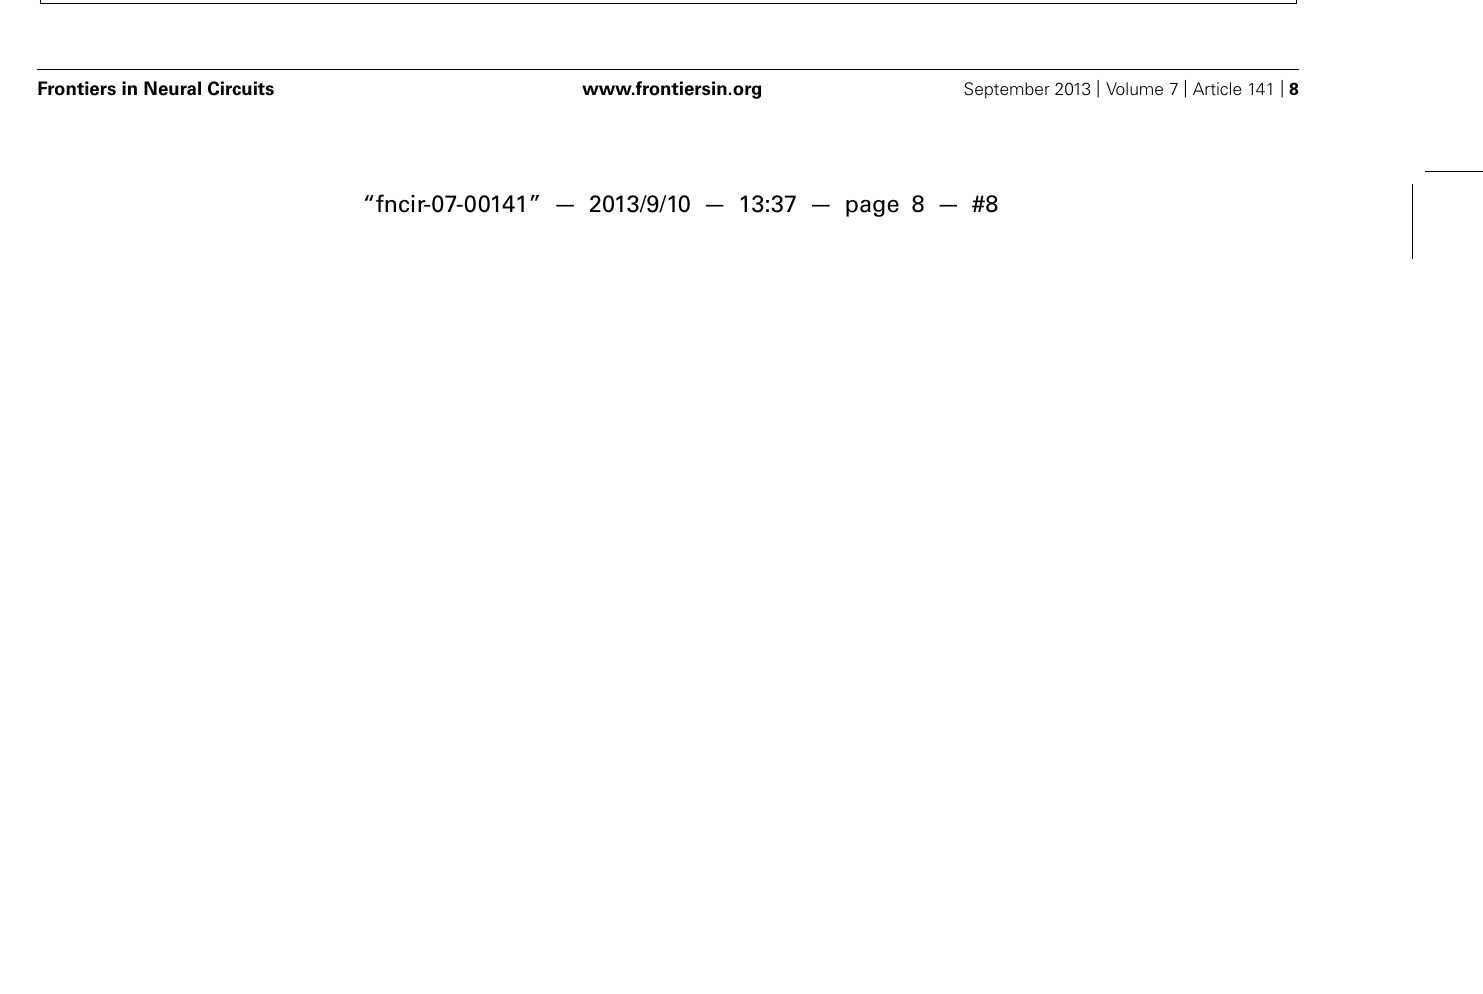
on average by 68% ( g 1 (1) = 0.76 [0.15 1.35], p = 0.014, n = 14), whereas the proportion of time spent in bursts showed a weak opposite effect ( g 1 (1) = − 0.45 [ − 0.99 0.11], p = 0.14, n = 14).There was no evidence for an effect on average firing rates ( g 1 (1) = 0.11 [ − 0.63 0.85], p = 0.77, n = 7). (E) Comparison of the effects of 250 nM NO-711 alone and with prior application of CGP 55845 and bicuculline: median burst duration (left), proportion of time spent in bursts (center) and average firing rate (right). All data were normalized to the respective control (absence of NO-711). Full symbols and error bars are means ± sd; gray symbols are data from individual experiments. (F) Statistical analysis of the data shown in (E) .The plot depicts, for each of the three parameters shown in (E) , standardized mean differences (termed g (cid:3) ) between the conditions [NO-711] and [GABA receptor antagonist and NO-711]. Error bars are 95% confidence